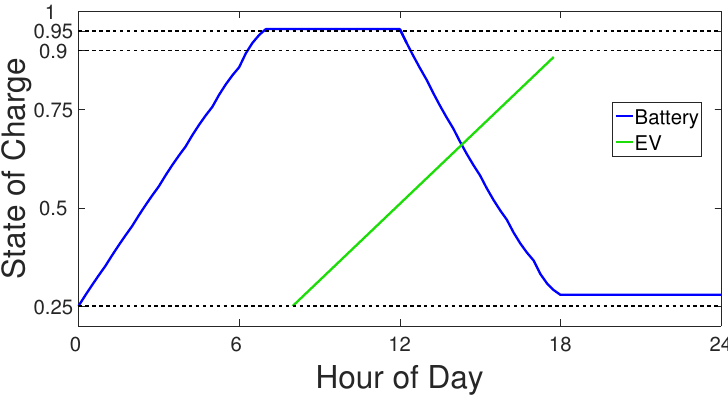
Figure 4. State of charge for the battery storage and electric vehicle (EV) system under the rules-based base